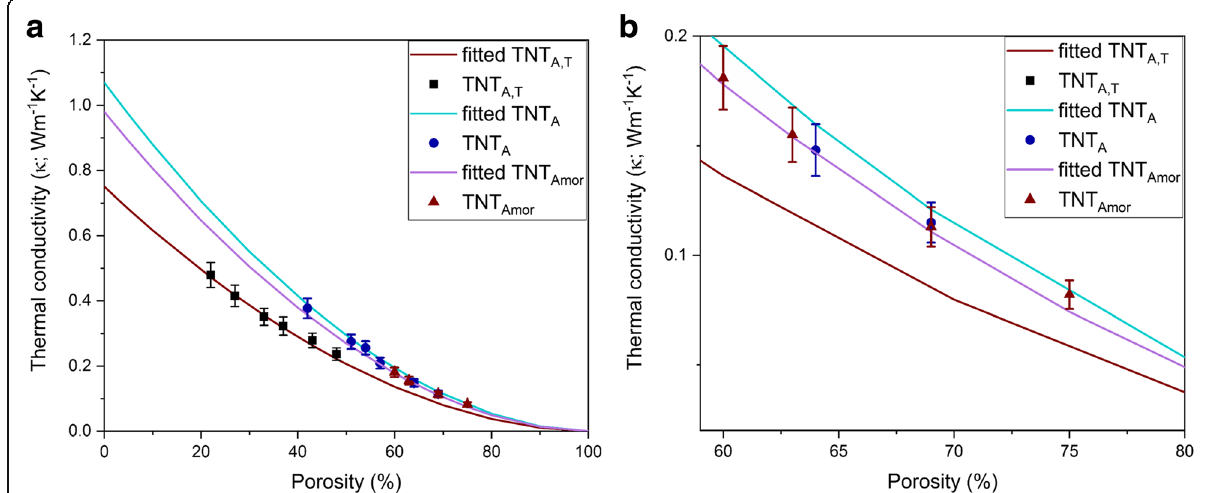
Fig. 4 a Measured effective thermal conductivity of the titania nanotubes (symbols) versus porosity. The solid lines represent fitting using the effective thermal conductivity model (Eq. 6) with a shape factor of 1.24. b Thermal conductivity over the range of 60 – 80% porosity for